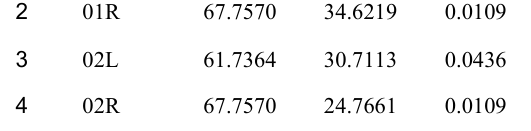
Figure 6. Original and steganography